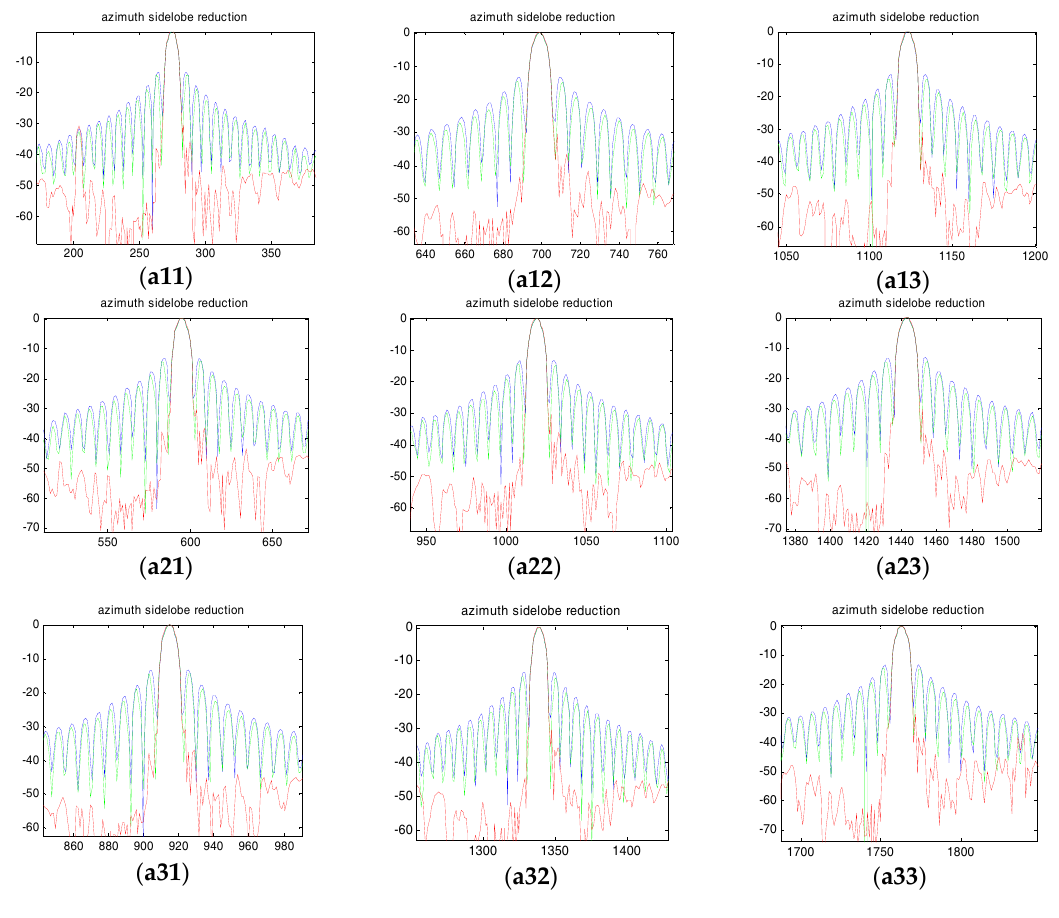
Figure 12. Azimuth profiles for the nine points. ( a11 ~ a33 ) are the nine points’ azimuth profiles, respectively.